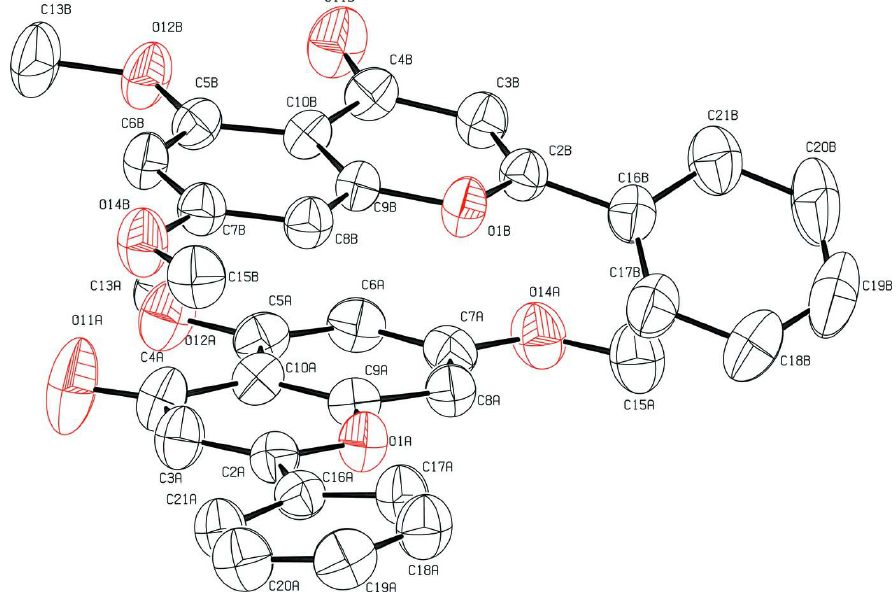
The asymmetric unit of the title compound with displacement ellipsoids shown at the 50% probability level for all non-H atoms. H-atoms are drawn as spheres of arbitrary